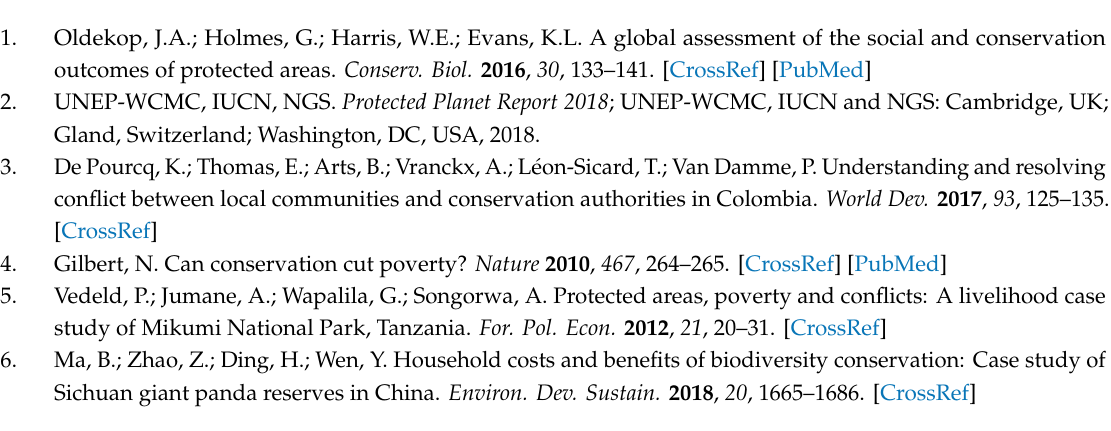
List of articles covered in this